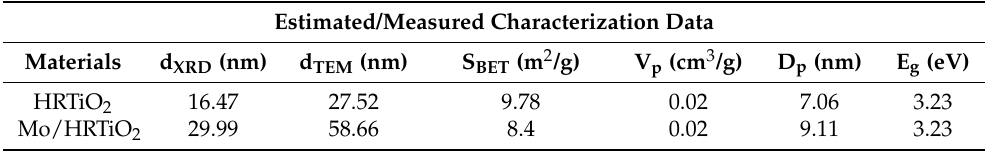
Table 1. Properties of unmodified and Mo modified HRTiO 2